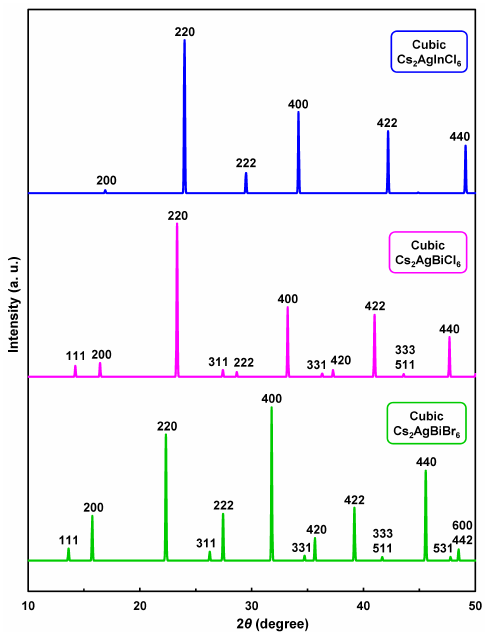
Figure 24: Calculated X-ray diffraction patterns of Cs 2 AgInCl 6 , Cs 2 AgBiCl 6 , and Cs 2 AgBiBr 6 double perovskites.